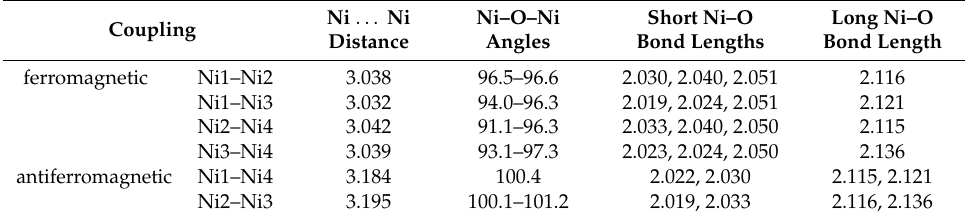
Table 6. Structural characteristics of the Ni 2 O 2 bridges in [Ni 4 ] from the X-ray structure